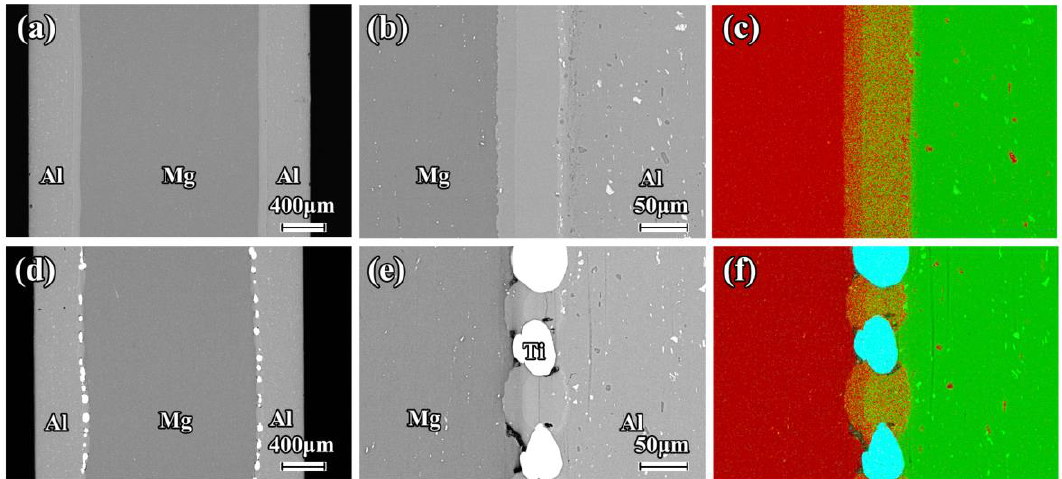
Figure 3. Low magnification and high magnification cross-sectional SEM micrographs of composite sheet after annealing at 400 °C for 3 h: ( a – c ) Mg/Al, and ( d – f ) Mg/Al - Ti. EDS mapping showing the element distribution of Al (green points), Mg (red points), and Ti (blue points).